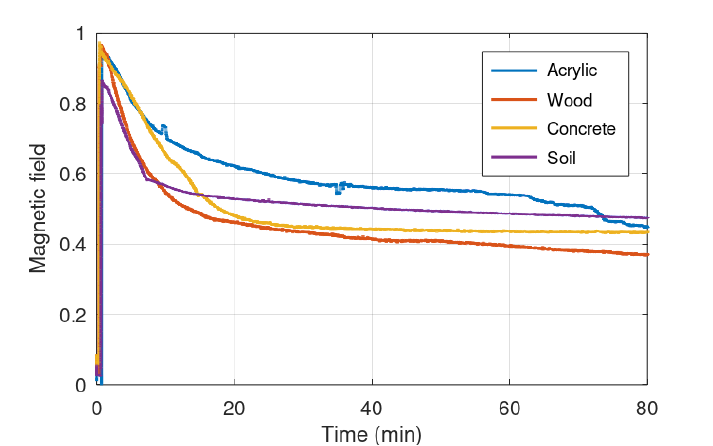
Figure 4. Normalized magnetic field intensity measured on z axis of magnetometer for several surfaces as a function of time. Magnetic field were measured on center of the and 10 mm above surface level. Reported environment temperature was 20 °C and 90%